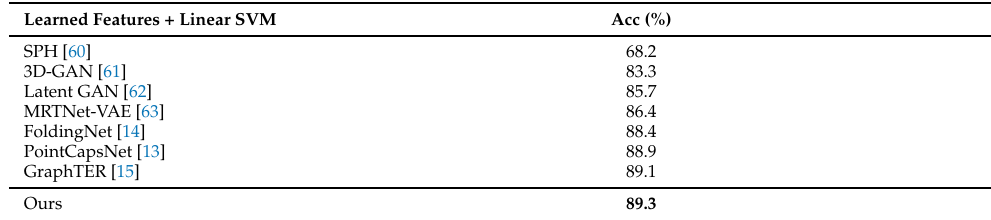
Table 5. Classification results in transfer learning from ShapeNet dataset to ModelNet40 dataset. The bold denotes the best performance.